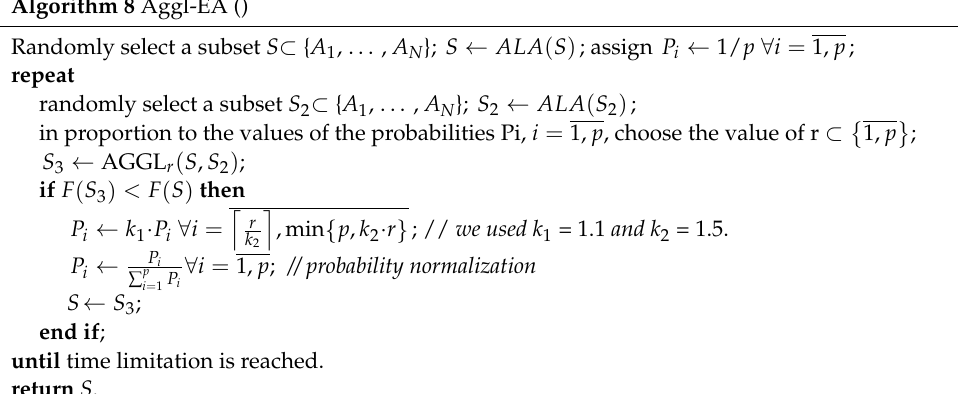
Algorithm 8 Aggl-EA